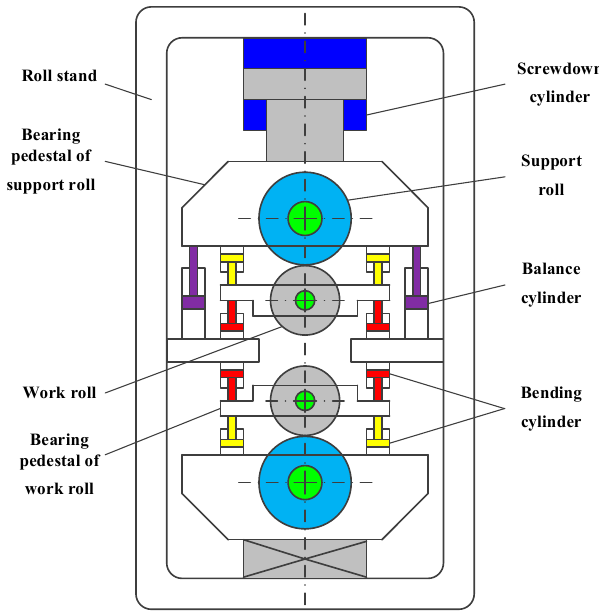
Figure 3. Structure diagram of four-high load roll system.